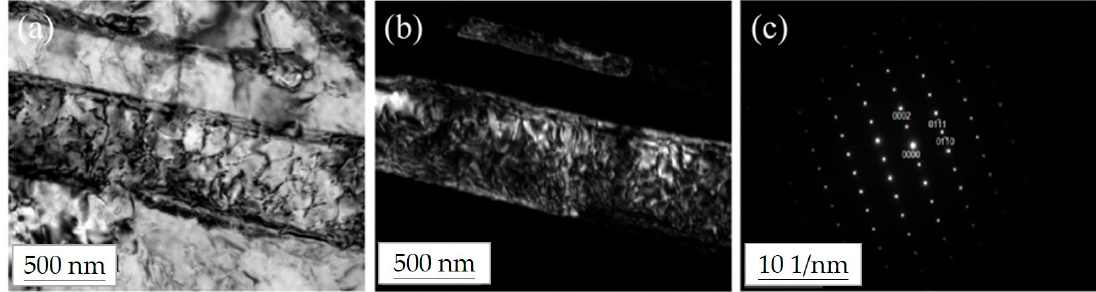
Figure 4. TEM (transmission electron microscopy) images for Ti–12Nb–1Ag, including: ( a ) Bright field image, ( b ) Dark field image, and ( c ) [110] axis. These indicate that the material has an acicular hexagonal close packing (HCP) structure.